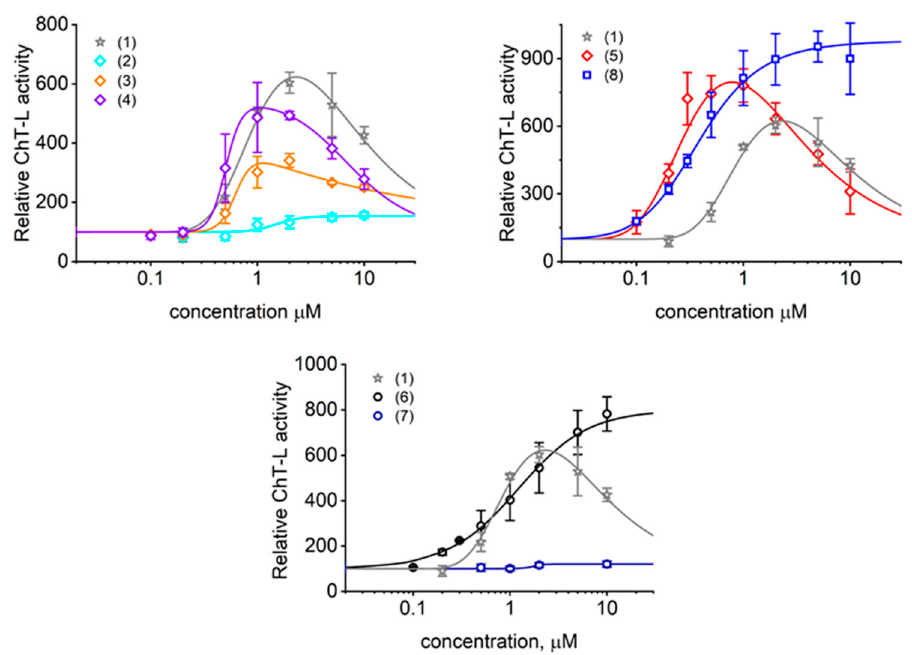
Figure 3. The chymotrypsin-like activity of latent human 20S proteasome was activated by TAT1 (1) and its derivatives in a dose dependent manner. (4) − (5) with turn inducers at the 8,9 position all outperformed (3) with a TO turn inducer at the position 4,5. Interestingly, (2) that contains TO and TOD turn inducers at the positions 4,5 and 8,9, respectively, was a very poor activator. (8) exhibited the highest fold of activation potential and a very low AC 50 . No ability to activate was detected for (7) where all lysines were substituted with alanines and for (9) with alanines replacing turn-promoting residues (not shown). Means ± SD, n = 3–8. The control activity presented as 100% corresponded to 5 nanomoles of the fluorescent AMC product released per minute by 1 mg of 20S proteasome from the Suc-LLVY-AMC substrate